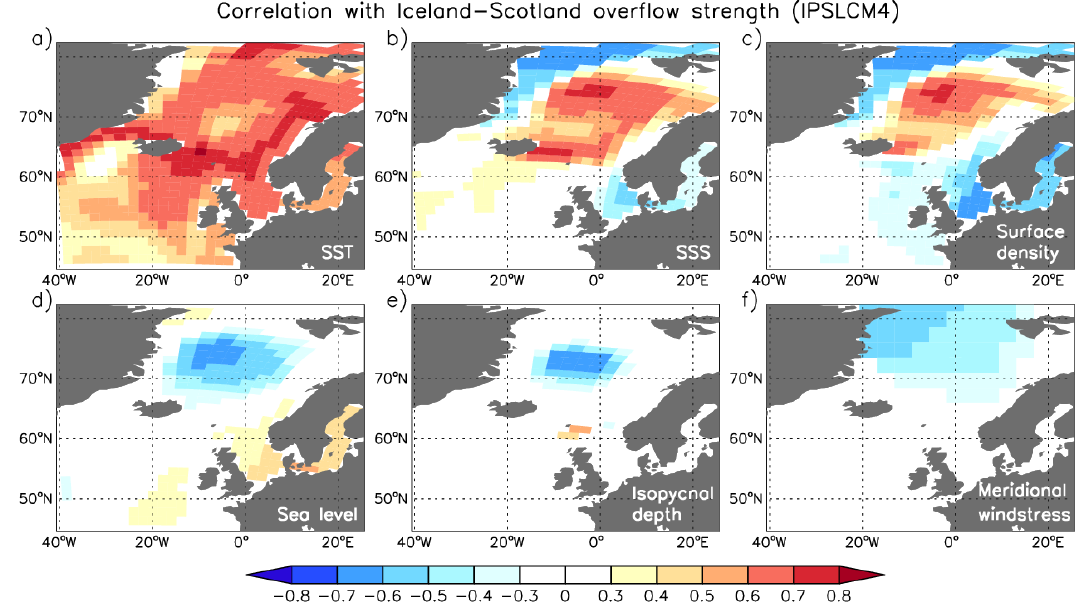
Figure 7. Zero-lag correlation coefficients between the Iceland–Scotland overflow strength and (a) the SST, (b) the SSS, (c) the surface density, (d) the sea surface height, (e) the depth of the isopycnal σ = 27 . 8kgm − 3 and (f) the meridional wind stress component in IPSLCM4. The correlation analysis is based on annual values for the period AD850 to 1849 with a 21-year running mean filter applied. The data have been linearly detrended prior to the analysis to account for the model drift. Only correlation coefficients statistically significant at the 95% confidence level are shown (significance level: 0.27).